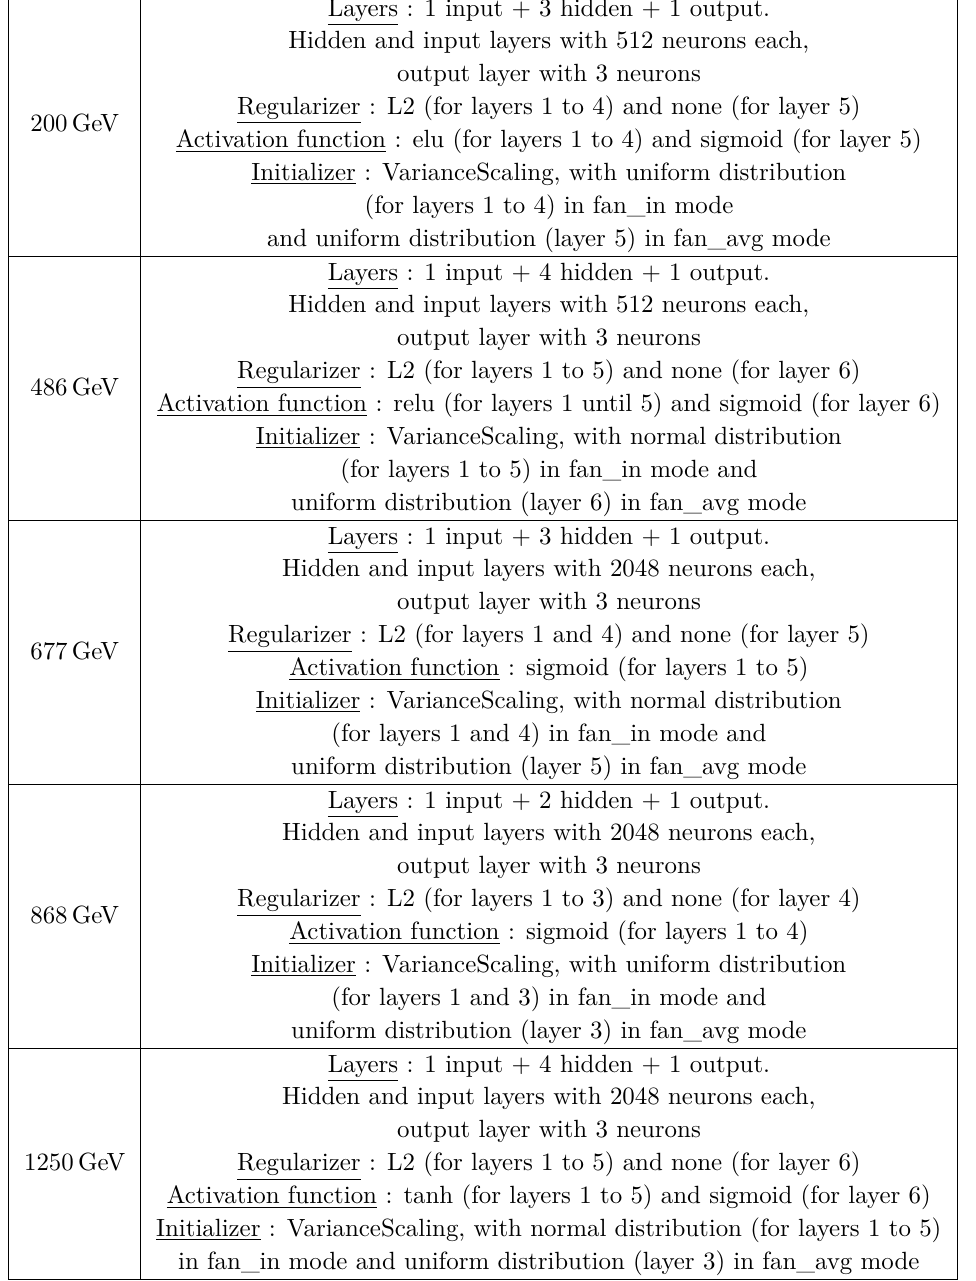
Table 11. Neural networks architectures employed for each mass of the lightest VLL for VBF channel. The architecture is determined following the implementation of an evolutive algorithm that maximizes the accuracy